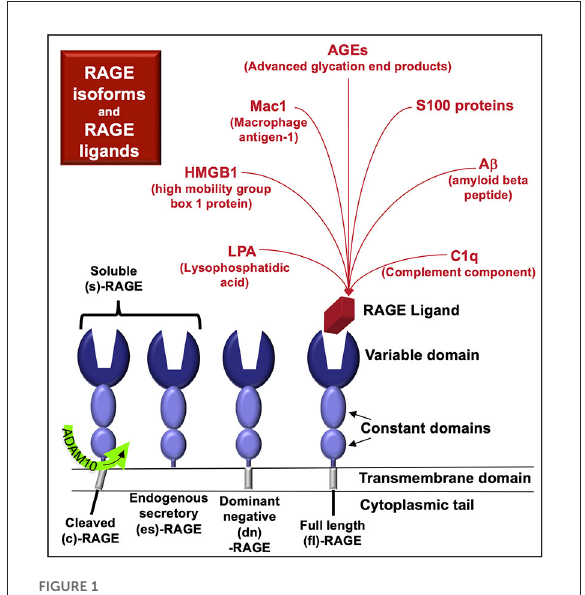
FIGURE1 RAGE and RAGE ligands . RAGE variants characterized at the protein level include full-length (fl)-RAGE, endogenous secretory (es)-RAGE, and dominant negative (dn)-RAGE. RAGE may also be cleaved from the cell surface by proteases (cRAGE) and function similarly to esRAGE. RAGE in serum or plasma is termed soluble (s)-RAGE and can include cRAGE and/or esRAGE. Competitive binding interactions may exist among the various RAGE proteins for RAGE